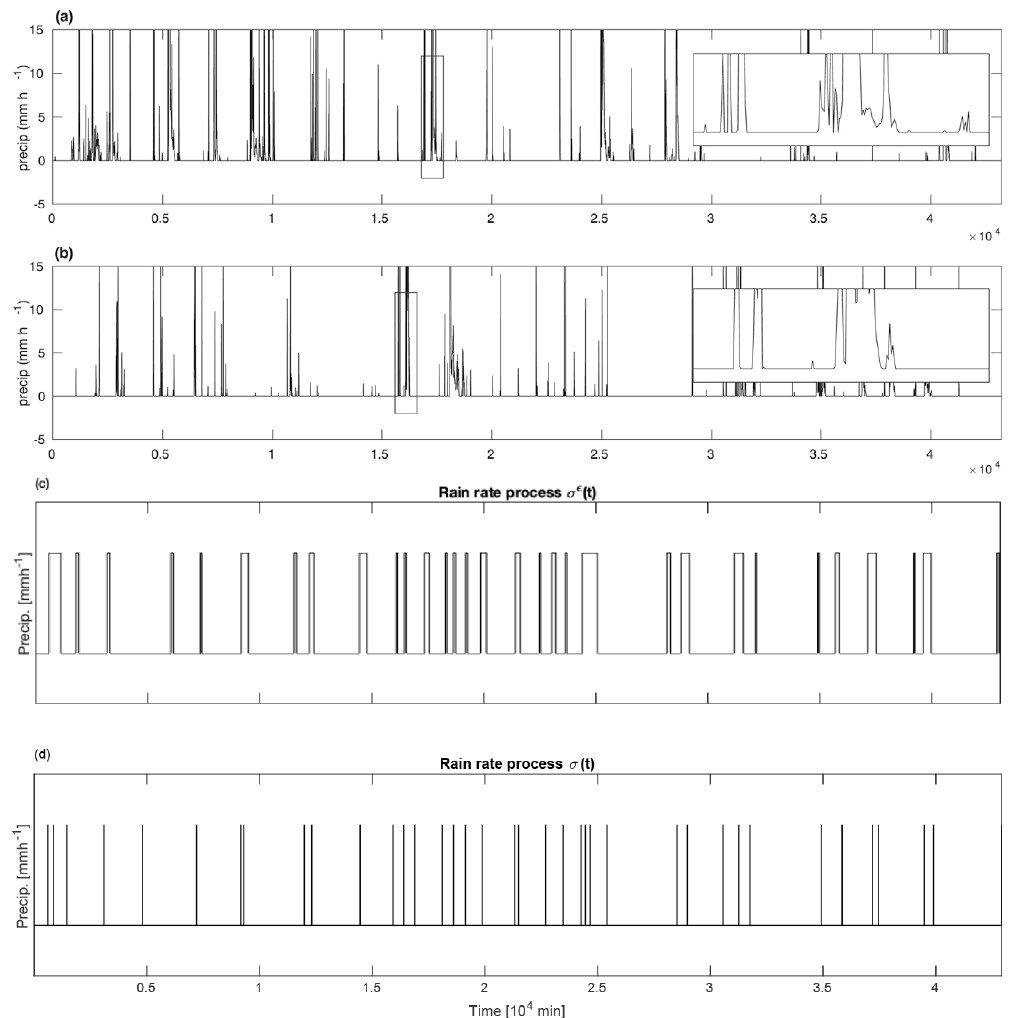
Figure 1. Sample precipitation time series from observations at (a) Manus Island and (b) Nauru reproduced from Fig. 3 of Abbott et al. (2016) with permission from the authors. The latter two panels are stochastic model simulations of (c) the rain rate process σ (cid:15) ( t ) with finite rain rate r and (d) σ ( t ) as the point